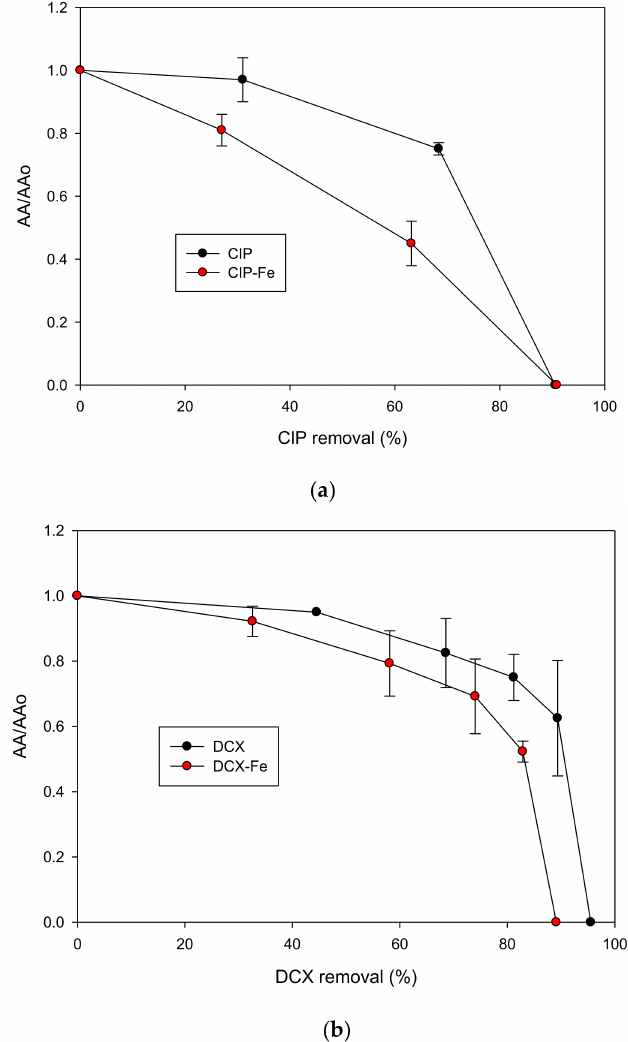
Figure 4. Antimicrobial activity (AA) evolution for CIP ( a ) and DCX ( b ) and their ferric complexes under the UVC action. Experimental conditions: [CIP]: 5.0 µ mol L − 1 /[Fe (III)]: 2.5 µ mol L − 1 , [DCX]: 2.5 µ mol L − 1 /[Fe (III)]: 2.5 µ mol L − 1 ; pH initial